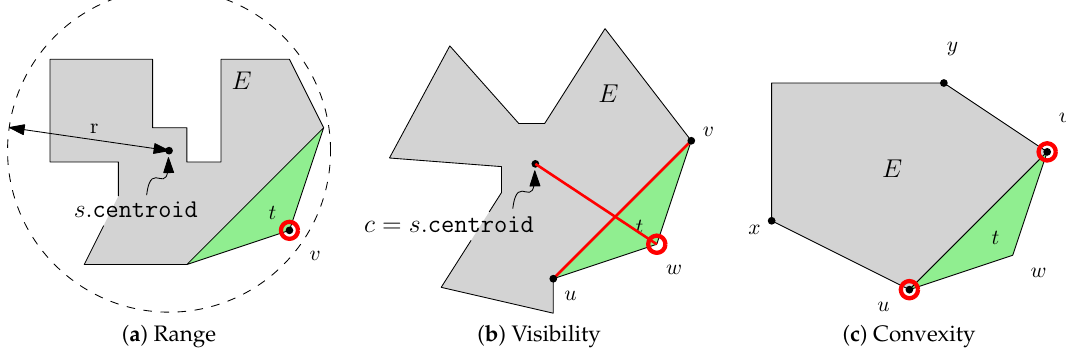
Figure 3. Checking the constraints with the current expansion E and the adding facet t